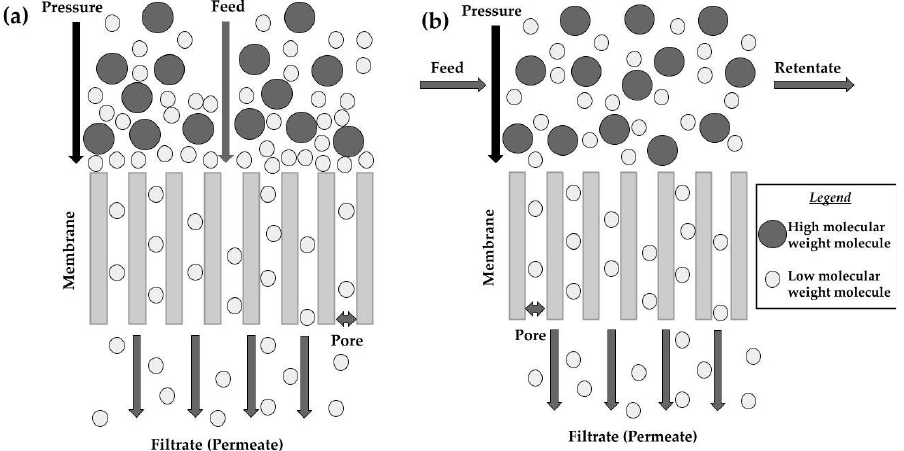
Figure 1. ( a ) Dead-end and ( b ) cross-flow filtration.